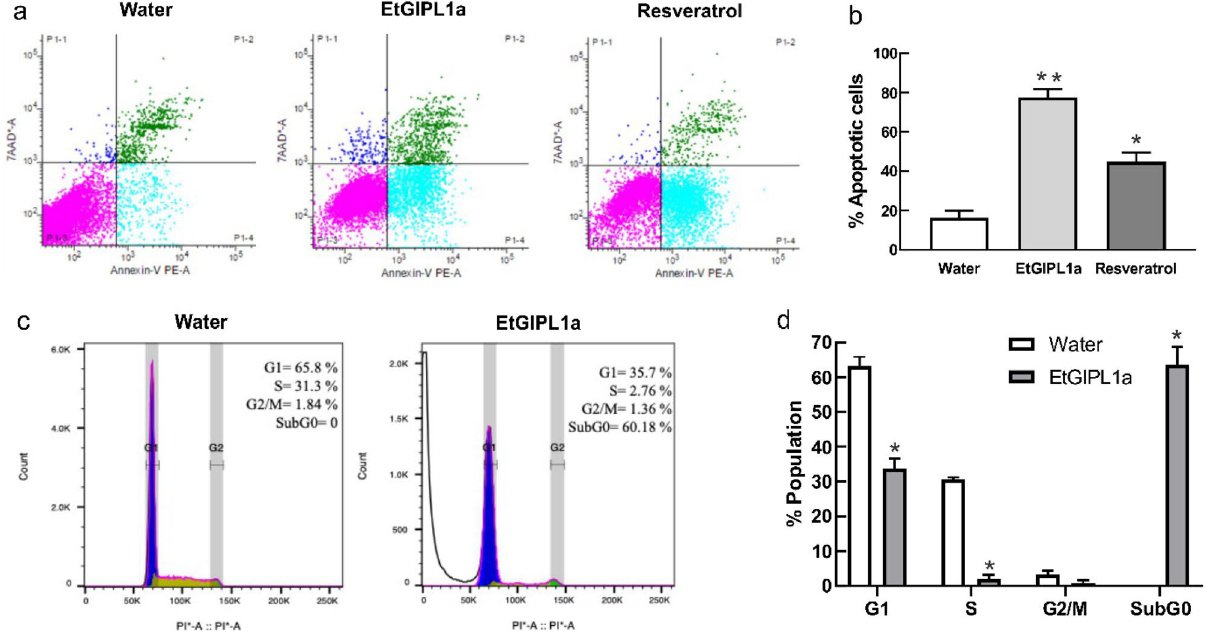
Figure 5. EtGIPL1a induces apoptosis in U251 glioblastoma cells. U251 cells were treated with 27 nM EtGIPL1a, 40 µM resveratrol or water for 48 h. Cell lysates were then subjected to flow cytometry analysis to measure the number of apoptotic cells as shown in ( a ). ( b ) Results from ( a ) and two additional experiments (n = 3) were pooled and plotted as shown. One-way ANOVA was used for statistical analysis. ** shows p = 0.0011 and * is p = 0.0102. ( c ) A representative result showing the % cell population in G1, S, G2/M and subG0 phases of U251 cell cycle upon treatment with 27 nM EtGIPL1a. ( d ) Results from three biological replicates were pooled and plotted as shown. One-way ANOVA was used for statistical analysis. * indicates p <